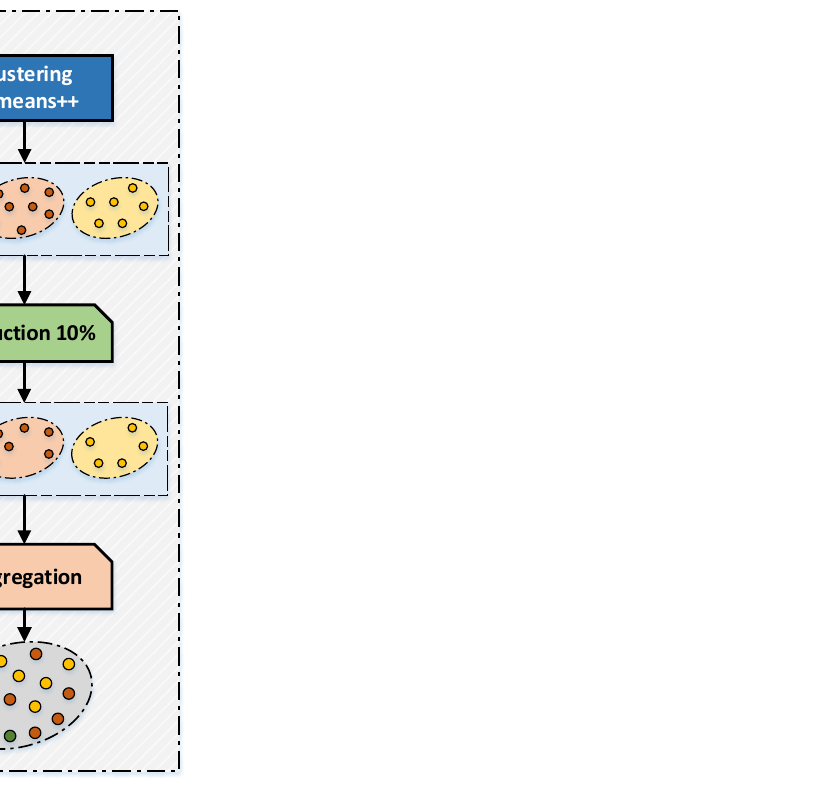
Figure 4. Data reduction with clustering stage using k -means++, a reduction by 10%, and the aggregation step.